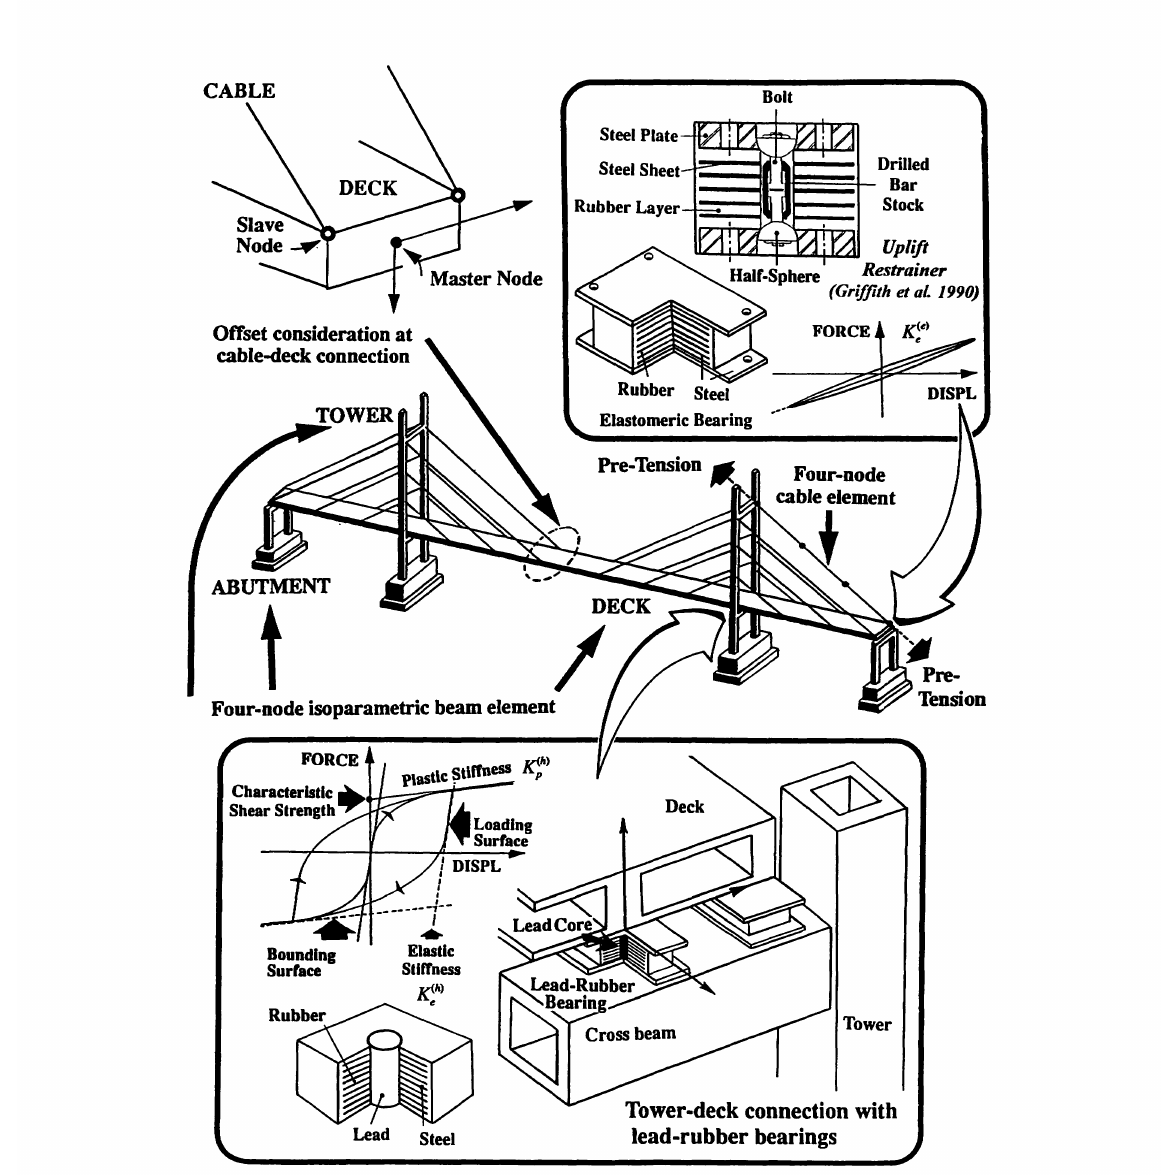
FIGURE 1 Modeling of cable-stayed bridges with passive control